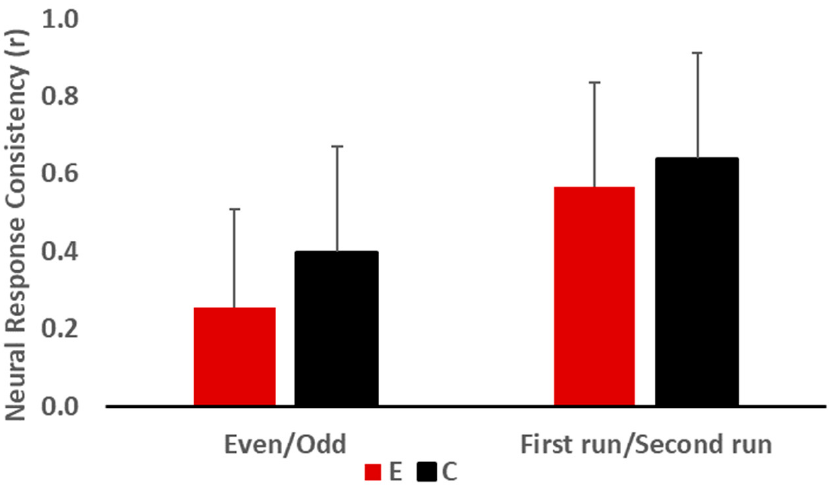
Figure 2. Neural response consistency (r) for the experimental (E) and the control (C) groups for even and odd events and the first and second runs of the recording.